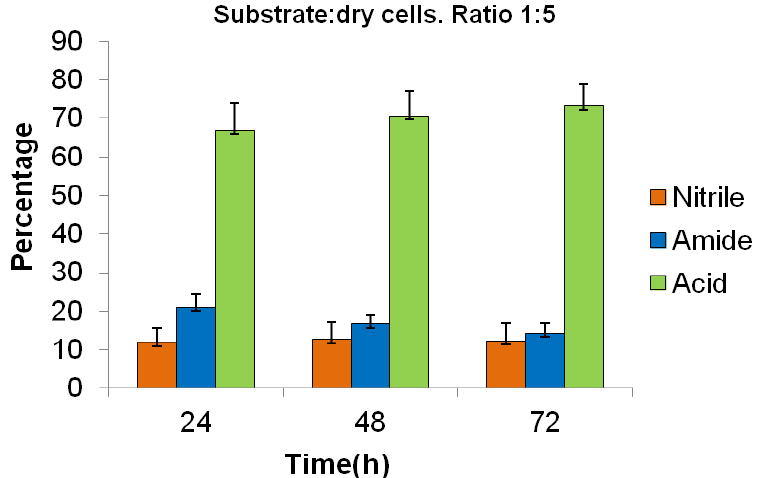
Figure 1. Biotransformation of ibuprofen nitrile 1 , using Method B, measured by GC. All the values were the mean of three independent experiments. Standard deviations for three independent experiments were represented by error